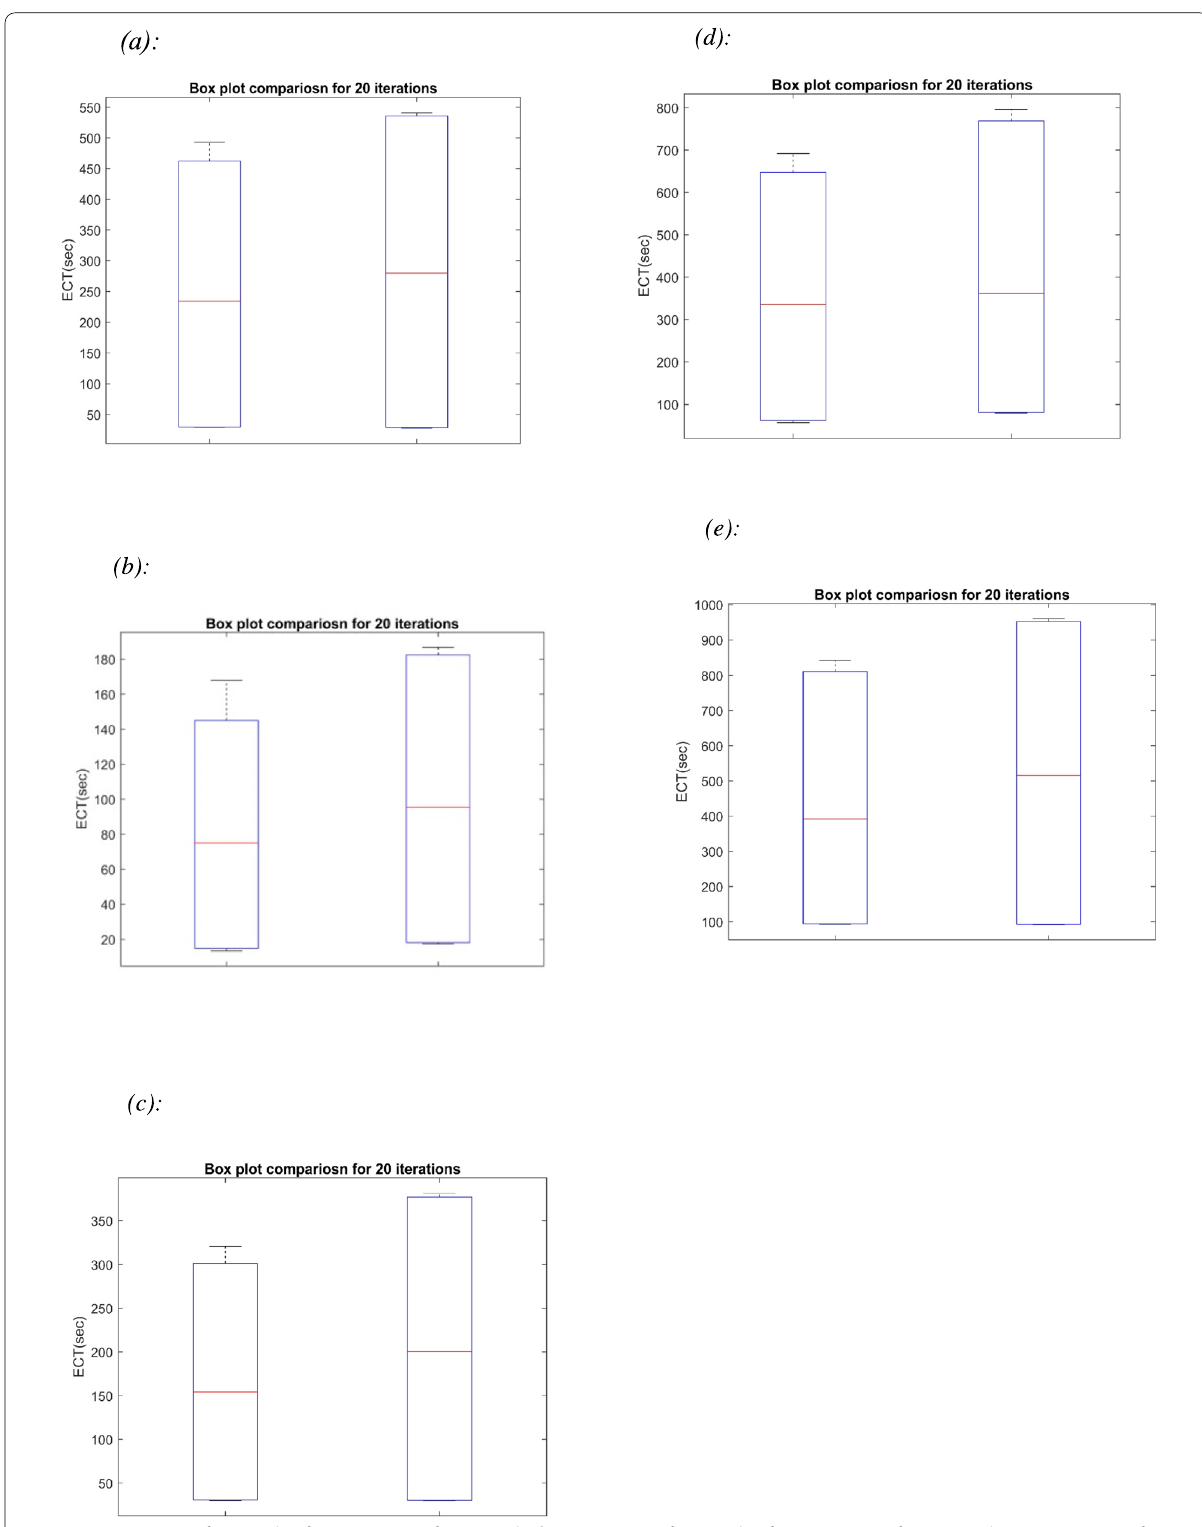
Fig. 6 a Comparison of IJFA and JS for 20 iterations for 600 Tasks. b Comparison of IJFA and JS for 20 iterations for 1200 Tasks. c Comparison of IJFA and JS for 20 iterations for 1800 Tasks. d Comparison of IJFA and JS for 20 iterations for 2400 Tasks. e Comparison of IJFA and JS for 20 iterations for 3000